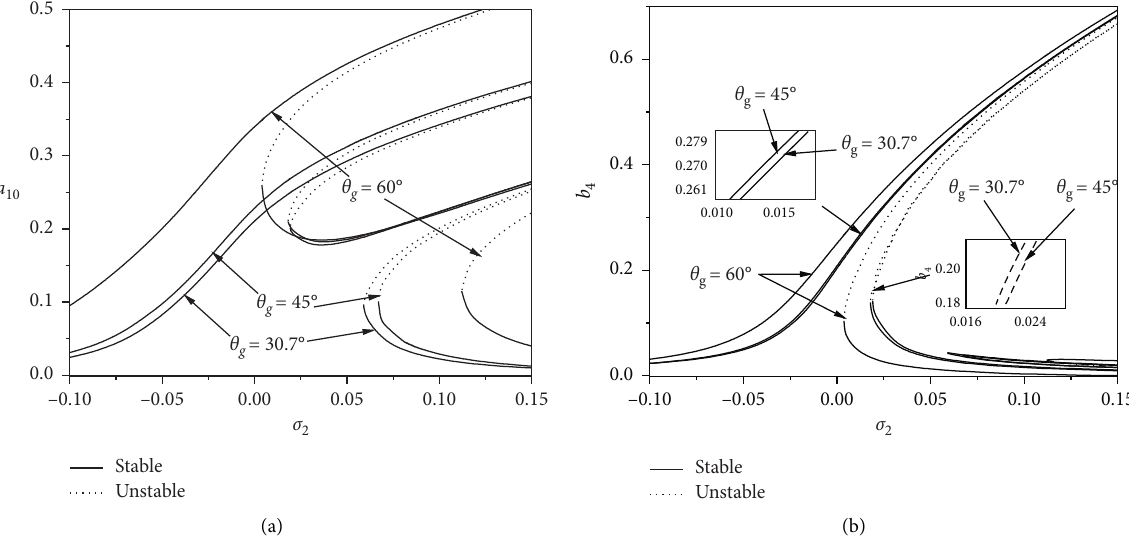
Figure 16: Effect of arch elevation θ g on the frequency-response curves of the (a) cable and (b) shallow arch with Ω 4 ≈ ω 2 , 4 and ω 1 , 10 ≈ ω 2 , 4